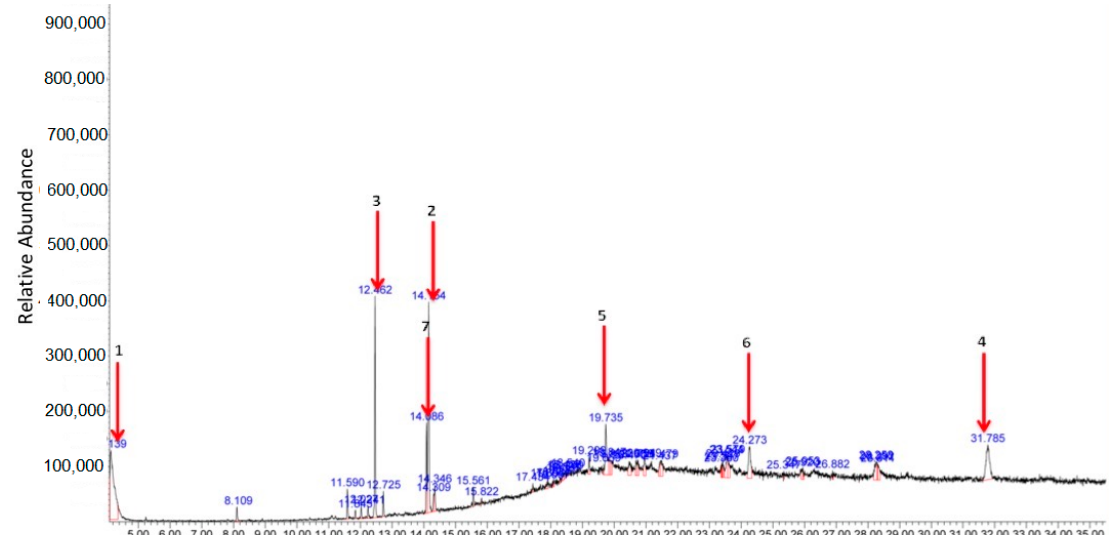
Figure 11. GC-MS profile of MEDL showing 48 detected peaks with 7 major peaks of area more than 4%. (i) Triphenylphosphine oxide (17.52%), (ii) 9,12,15-octadecatrienoic acid (13.43%), (iii) hexadecanoic acid (9.70%), (iv) tri(2-ethylhexyl) trimellitate (7.98%), (v) erucylamide (5.45%), (vi) 5,10-dihexyl-5,10-diihydroindolo[3,2-b]indole-2,7-dicarbaldehyde (4.63%) and (vii) linoleic acid (4.17%).